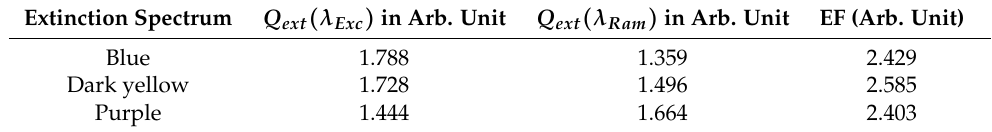
Table 2. Enhancement factor obtained with the E 4 model (in Arb. Unit). The values of extinction intensities are obtained from the Figure